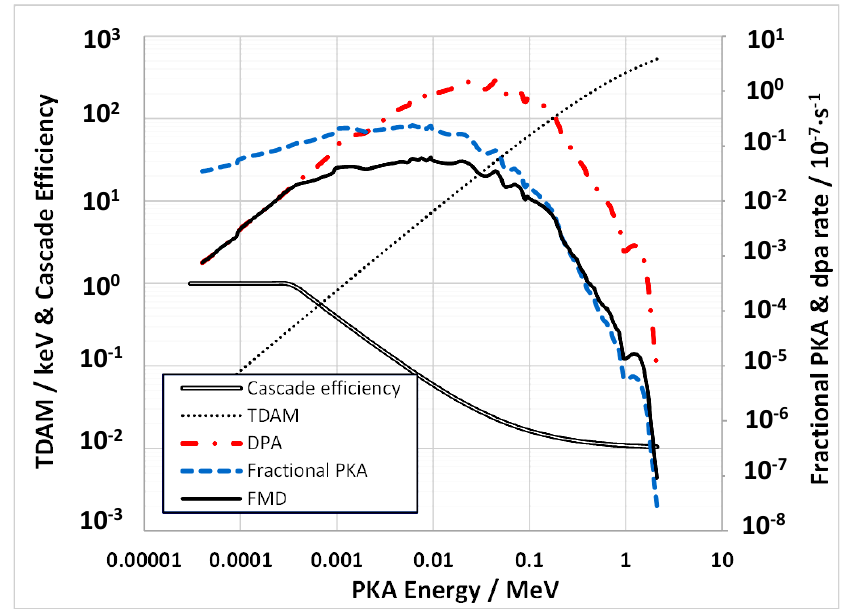
Figure 21. PKA spectrum, DPA and FMD for pure Fe in EBR-II 8D5 as a function of cascade energies for the different PKA values.